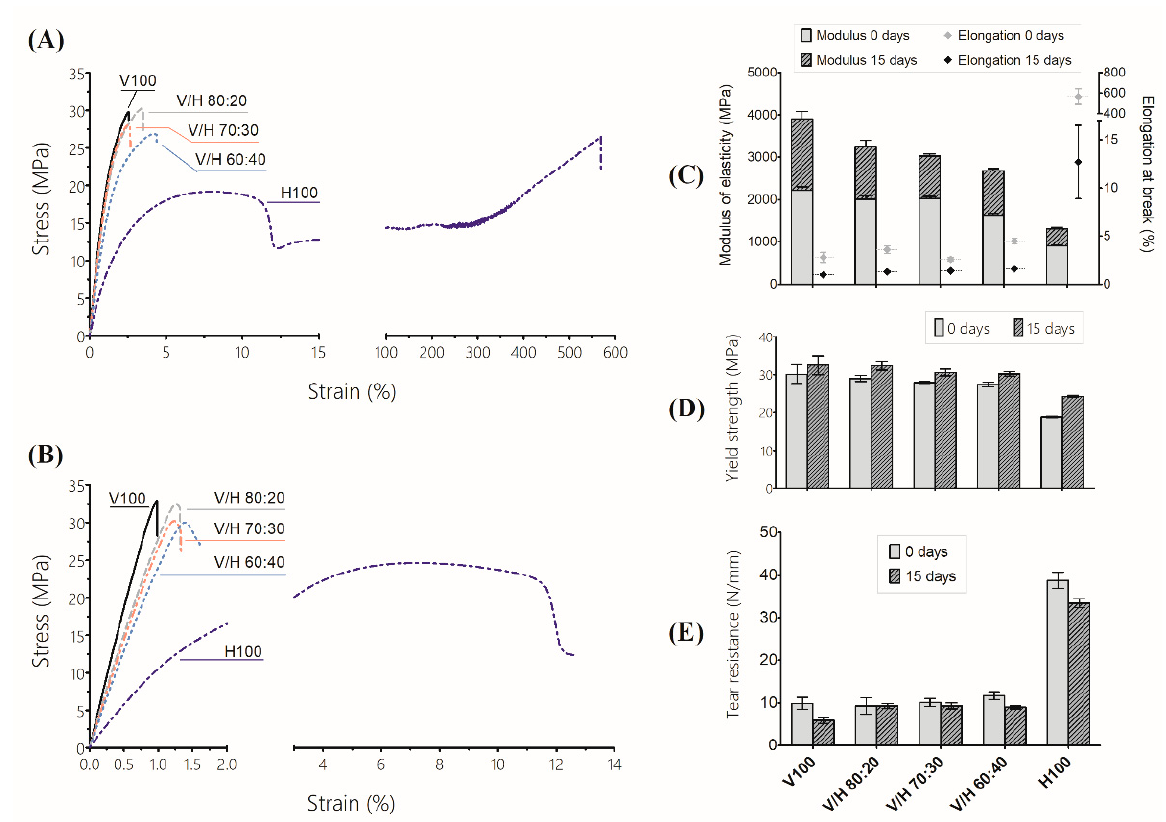
Figure Figure 10. Mechanical properties of poly(3-hydroxybutyrate- co -3-valerate) (PHBV), poly(3-hy- droxybutyrate- co -3-hydroxyhexanoate) (PHBH), and their blends: ( A ) Representative stress–strain curves at 0 days; ( B ) Representative stress–strain curves at 15 days; ( C ) Modulus of elasticity (bar, left axis) and elongation at break (dot, right axis); ( D ) Yield strength; ( E ) Tear resistance.